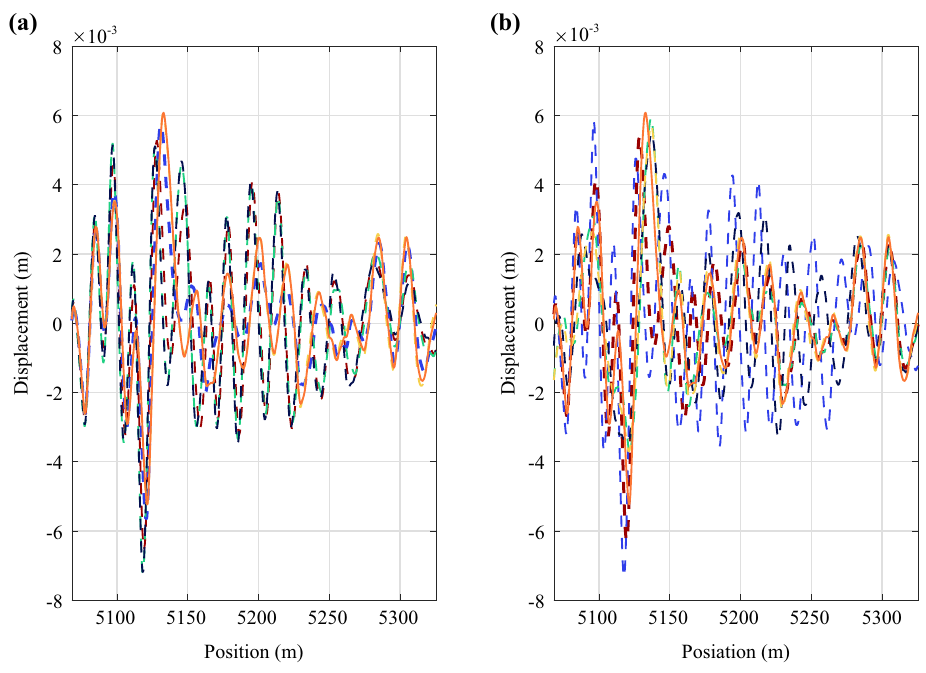
Fig. 20 Wheelset displacement before large dip at 5400–5440 m, with the same color scheme as in Fig. 18: a zoomed-in version of Fig. 18c, i.e., the displacement of the front wheelset for the original simulation and the five simulations with LOO noise; b zoomed-in version of Fig. 19c, i.e., the displacement of the front wheelset for the original simulation and the five simulations with ALOO noise. The figures show that the noise causes only slight differences in the dynamics of the